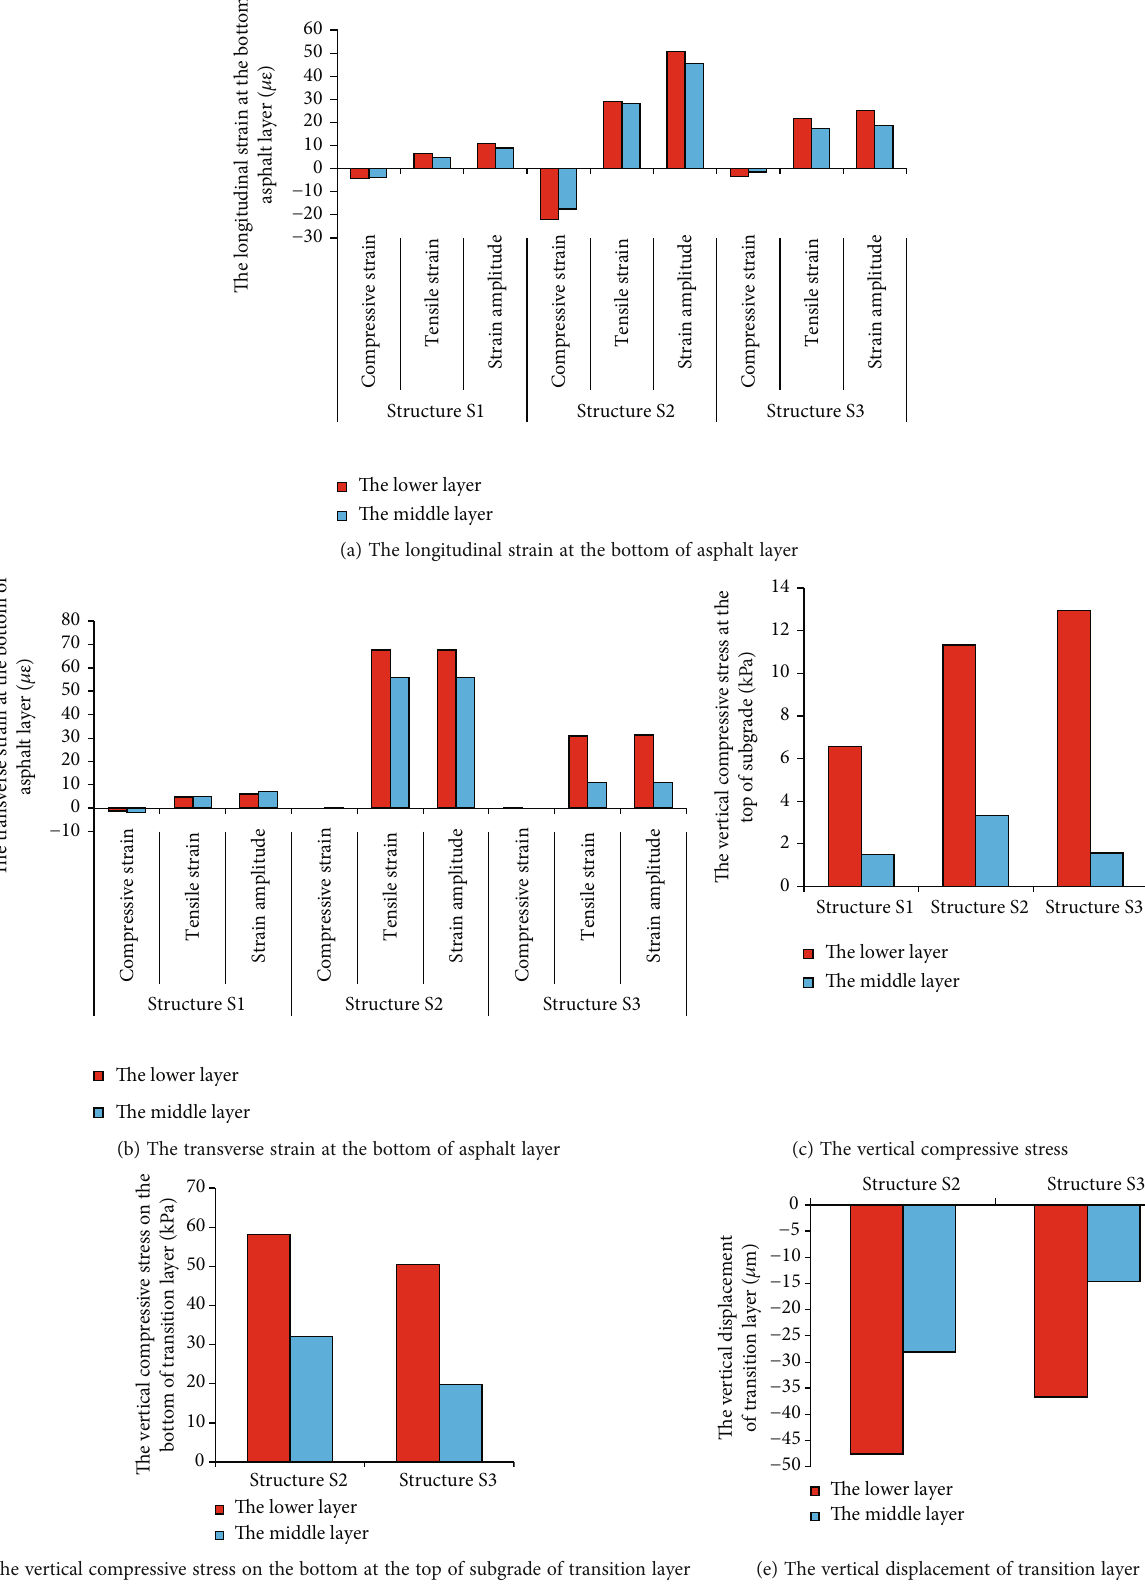
(d) The vertical compressive stress on the bottom at the top of subgrade of transition layer (e) The vertical displacement of transition layer Figure 10: Change of asphalt pavement response before and after middle layer